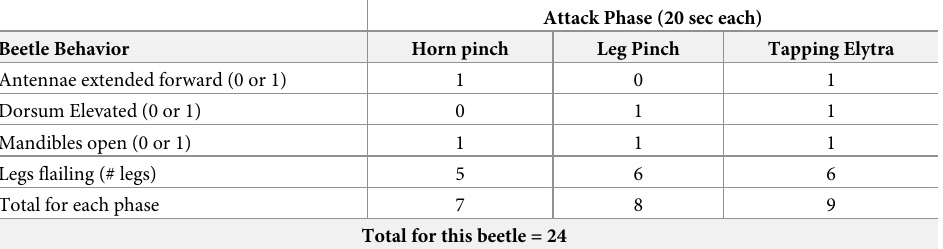
Table 1. Summary of scoring system used in this experiment to assess the magnitude of behavioral reactions observed during simulated attack. Shown is an example score from a beetle with a strong behavioral